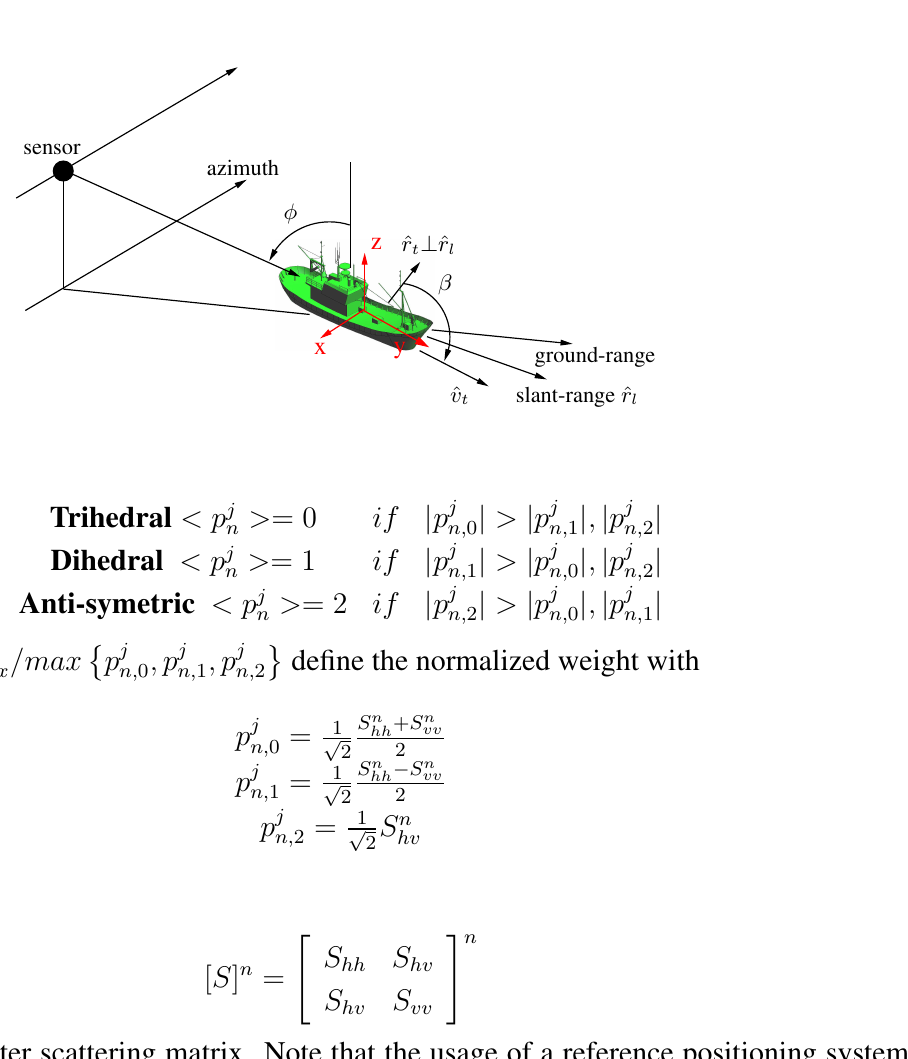
Figure 7. Local coordinate system used to define PePS within targets. The center is located at the center of